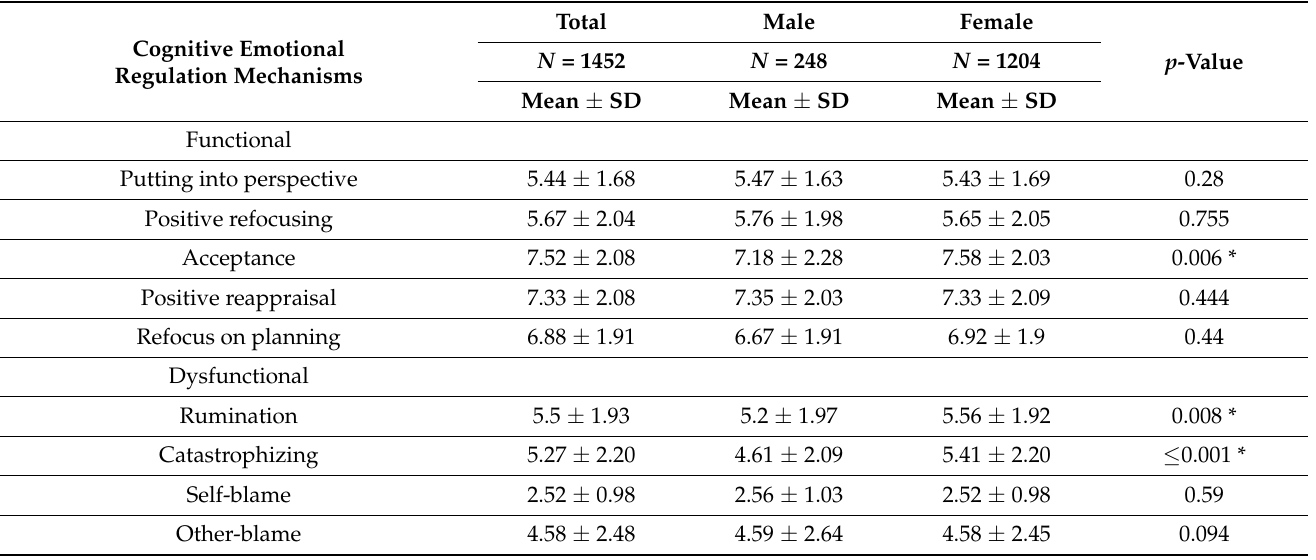
Table 1. Functional and dysfunctional cognitive emotional regulation mechanisms used by HCPs.